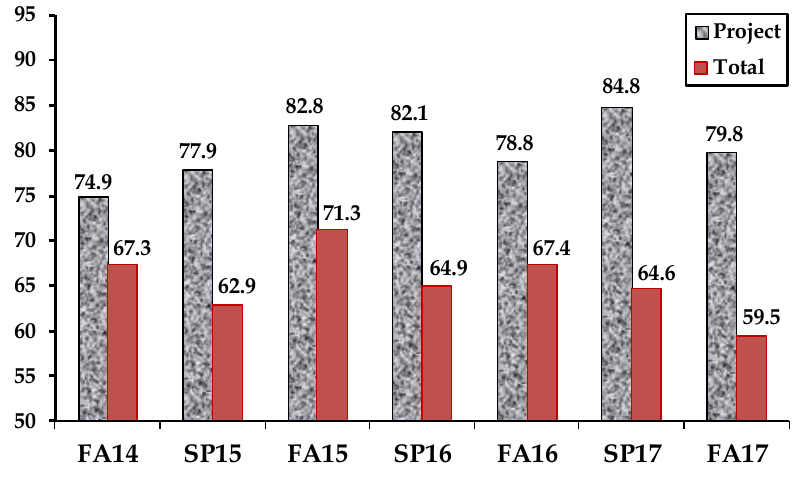
Fig. 3. Average performance of the students in projects vs. the total scores in ELEG